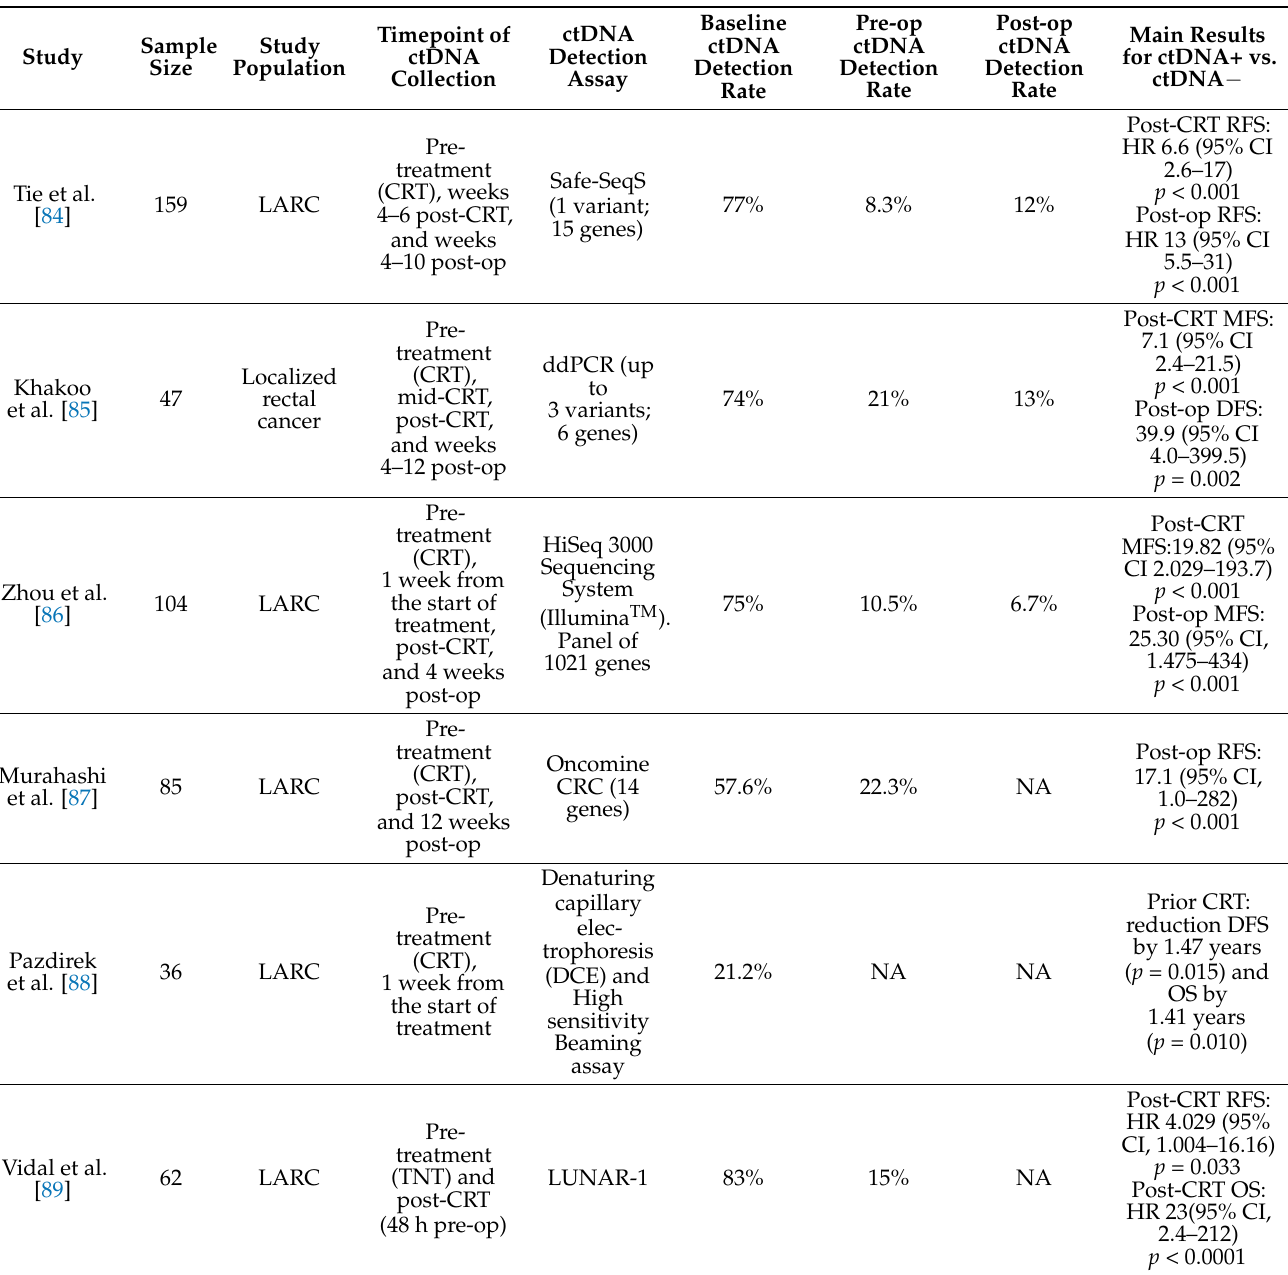
Table 2. ctDNA as prognostic marker in locally advanced rectal